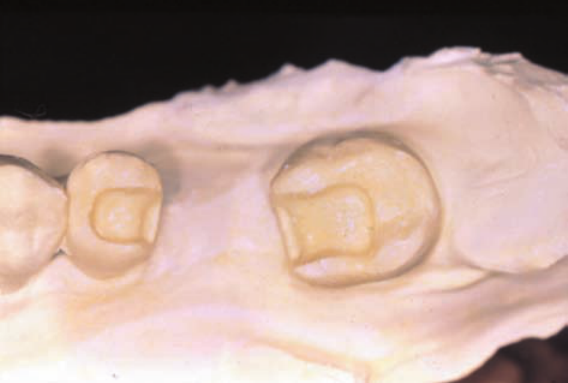
Figure 4- A closer view of the fiber-reinforced fixed partial denture after finishing and polishing procedures